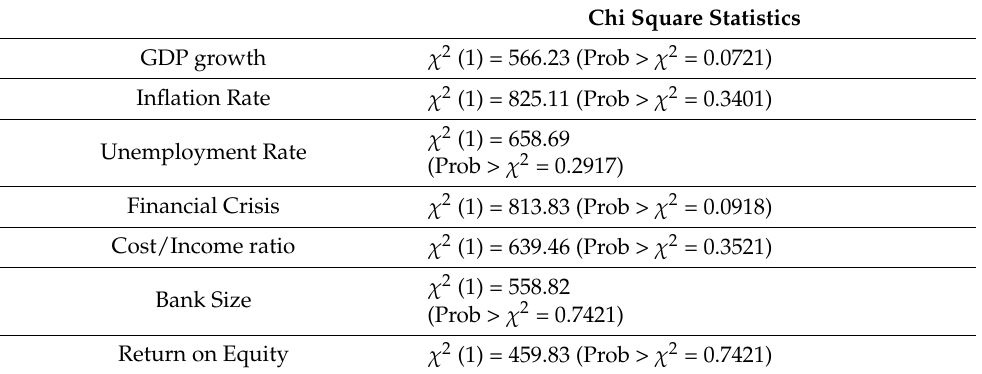
Table A4. The results for Heteroskedasticity using the Breusch-Pagan/Cook-Weisberg test (Greene 2003; Gujarati 2003). H 0 : the variance of error terms is constant (homogenous). H 1 : the variance of error terms is not constant